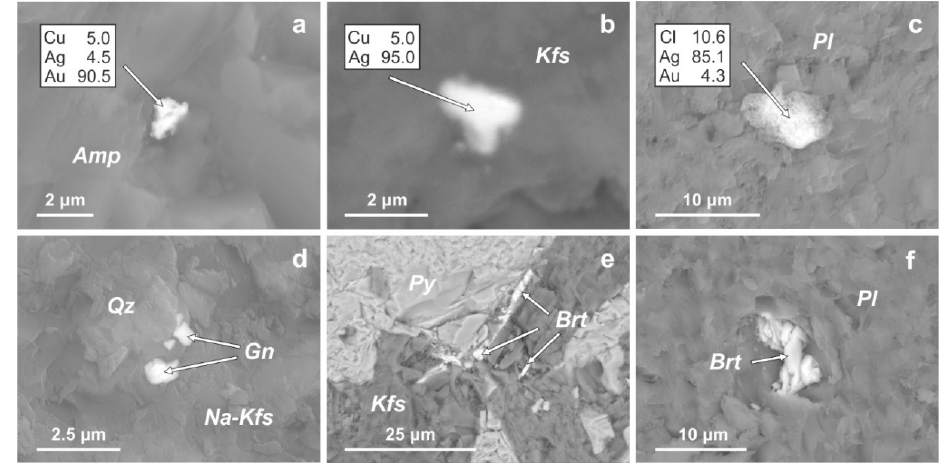
Figure 11. Cu–Ag–Au intermetallic compounds and associated sulfide and sulfate minerals in Stanovoy adakites: ( a ) Subhedral Cu- and Ag-bearing Au inclusion in amphibole (Amp); ( b ) euhedral Cu-bearing Au inclusion in K-feldspar (Kfs); ( c ) non-stoichiometric Au-bearing silver chloride inclusion in plagioclase (Pl); ( d ) euhderal galena (Gn) particles developed along the boundary between quartz (Qz) and Na–K-feldspar (Na-Kfs); ( e ) lamellar barite (Brt) crystals filling fractures between pyrite (Py) and K-feldspar (Kfs); ( f ) euhedral barite (Brt) inlcusions in plagioclase (Pl). All photos are SEM back-scatter electron (BSE) images.